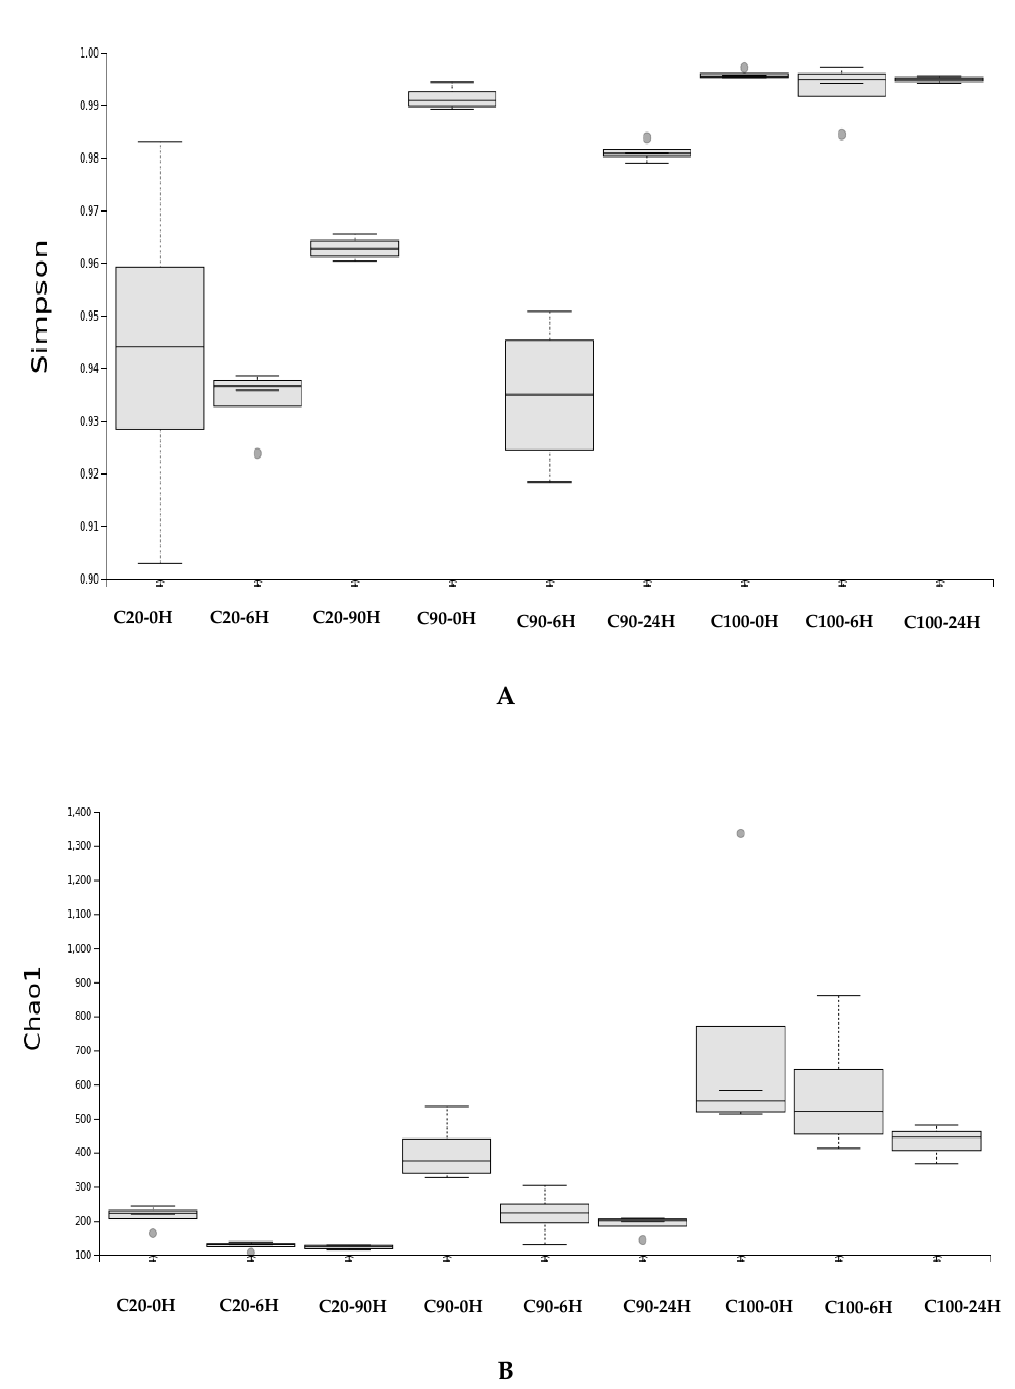
Figure 5. Box plots representing alpha diversity through the Simpson ( A ) and Chao 1 ( B ) uniformity index. T1 = 100% cactus forage; C100 = 100% cactus forage; C60 = 60% cactus forage and 40% buffel grass hay; C20 = 20% cactus forage and 80% buffel grass hay; 0H = 0 h; 6H = 6 h and 24H = 24 h of exposure to air.